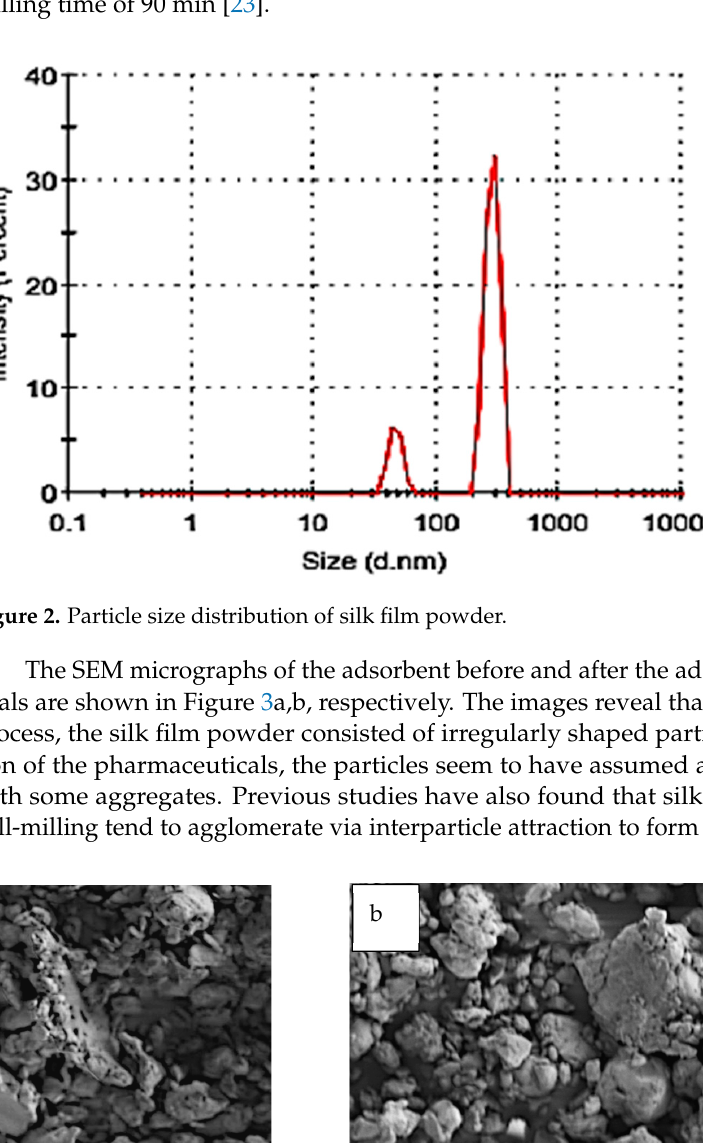
Figure 3. SEM images of silk film powder ( a ) before and ( b ) after adsorption of pharmaceuticals.